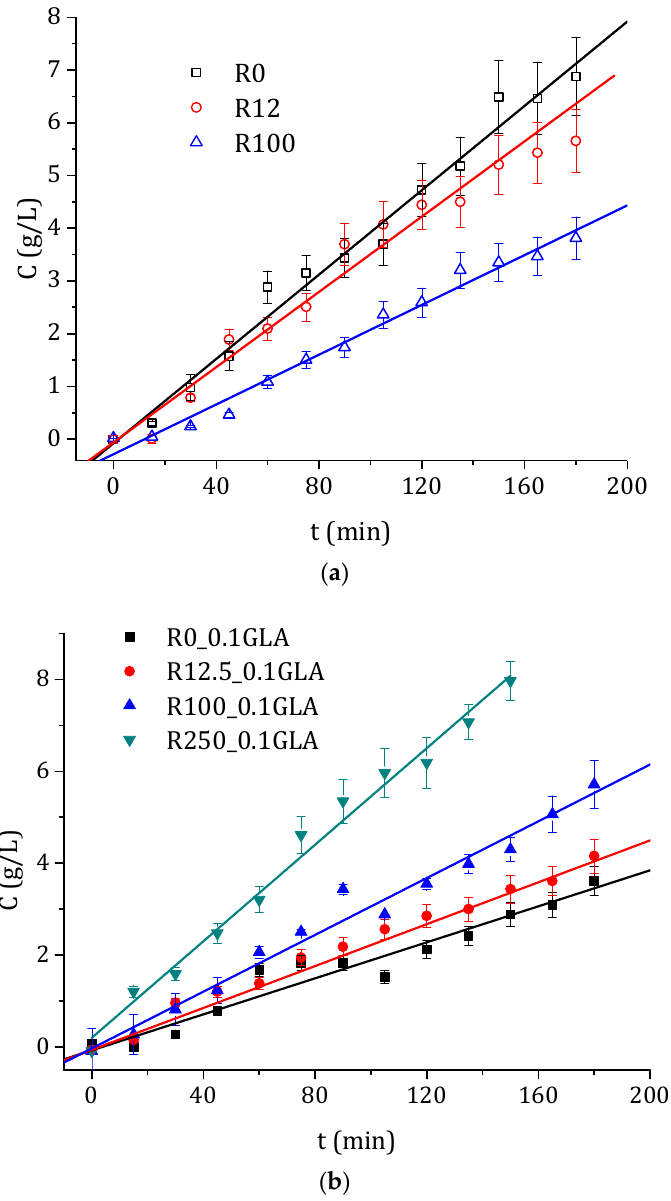
Figure 10. Temporal evolution of the concentration of SULF in the permeate side of the membranes prepared with non-irradiated and irradiated chitosan at different doses, ( a ) without and ( b ) with GLA in the chitosan solutions.